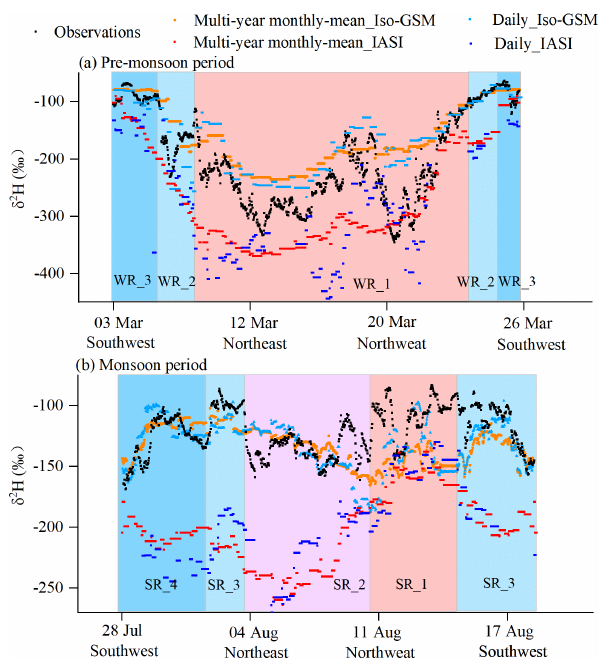
Figure 6. Comparison of observed vapor δ 2 H (observations) with outputs of isotope-enabled general circulation model Iso-GSM and satellite IASI during the pre-monsoon period (a) and monsoon pe- riod (b) . The results in this graph are from the daily and multiyear monthly outputs for the sampling locations.